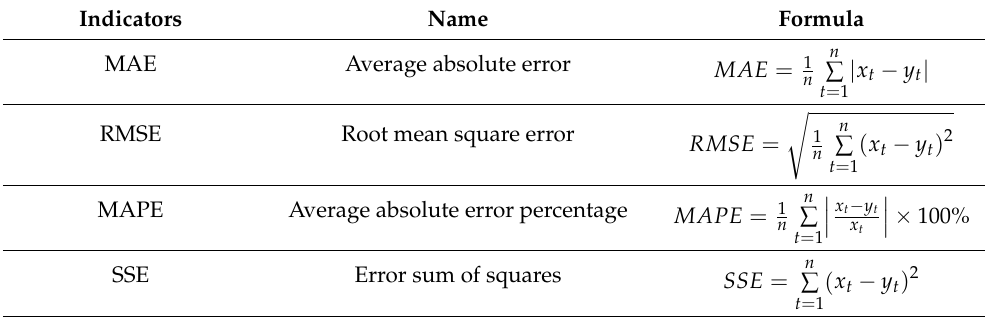
Table 3. Evaluation indicators.